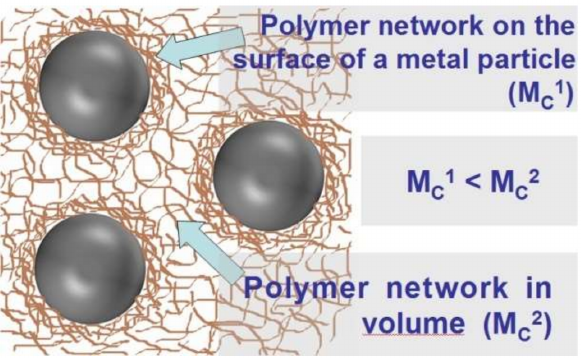
Figure 6. Scheme of polymer matrix structure formation in the presence of a metal